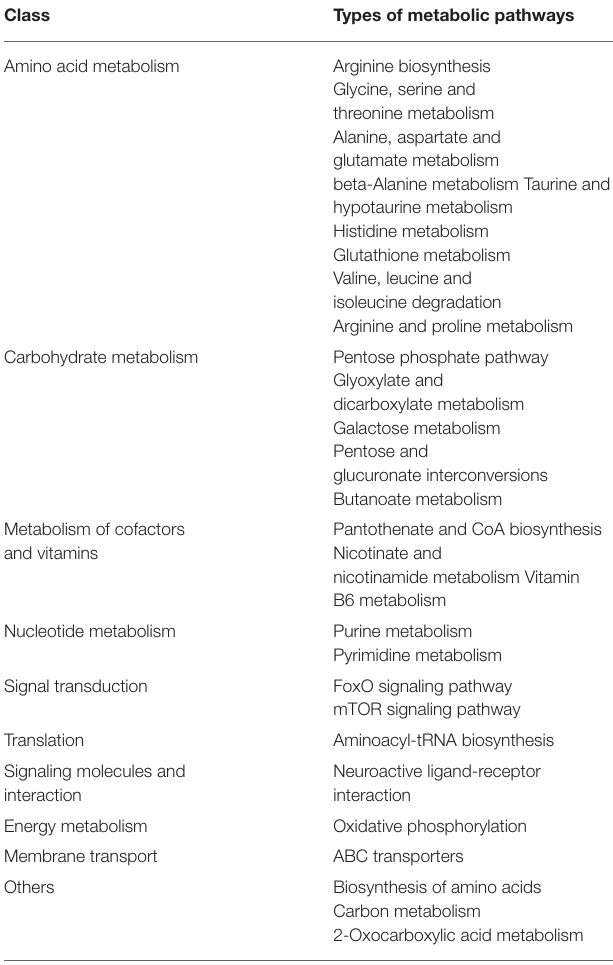
TABLE 4 | Classification of metabolic pathways significantly enriched in correlation analysis.